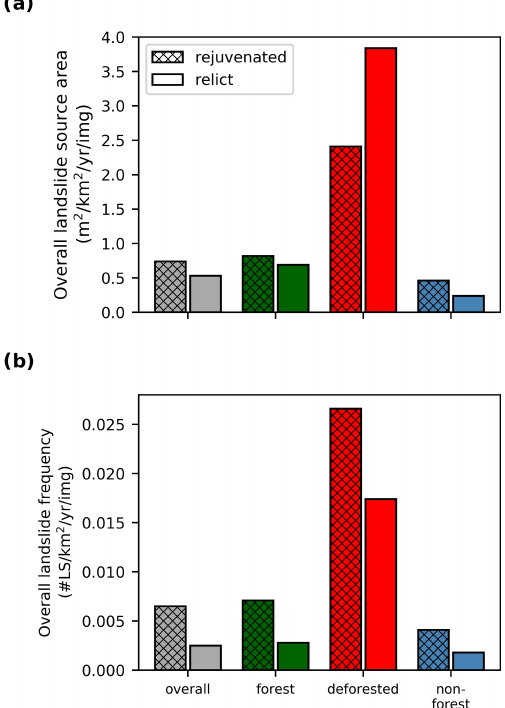
Figure 10. Total landslide activity in the NTK rift adjusted for im- agery density: (a) total landslide source area (LS S ), a proxy for landslide erosion, and (b) landslide frequency (LS F